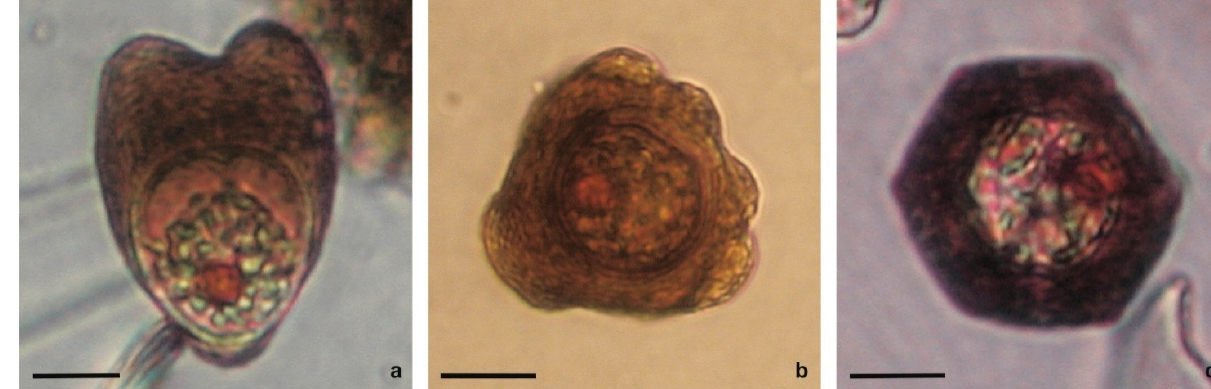
Figure 3. Cysts of Calciperidinium asymmetricum ( a ), Follisdinellum splendidum ( b ), and Melodomuncula berlinensis ( c ) found in sediment traps. Scale bar: 10 µm.